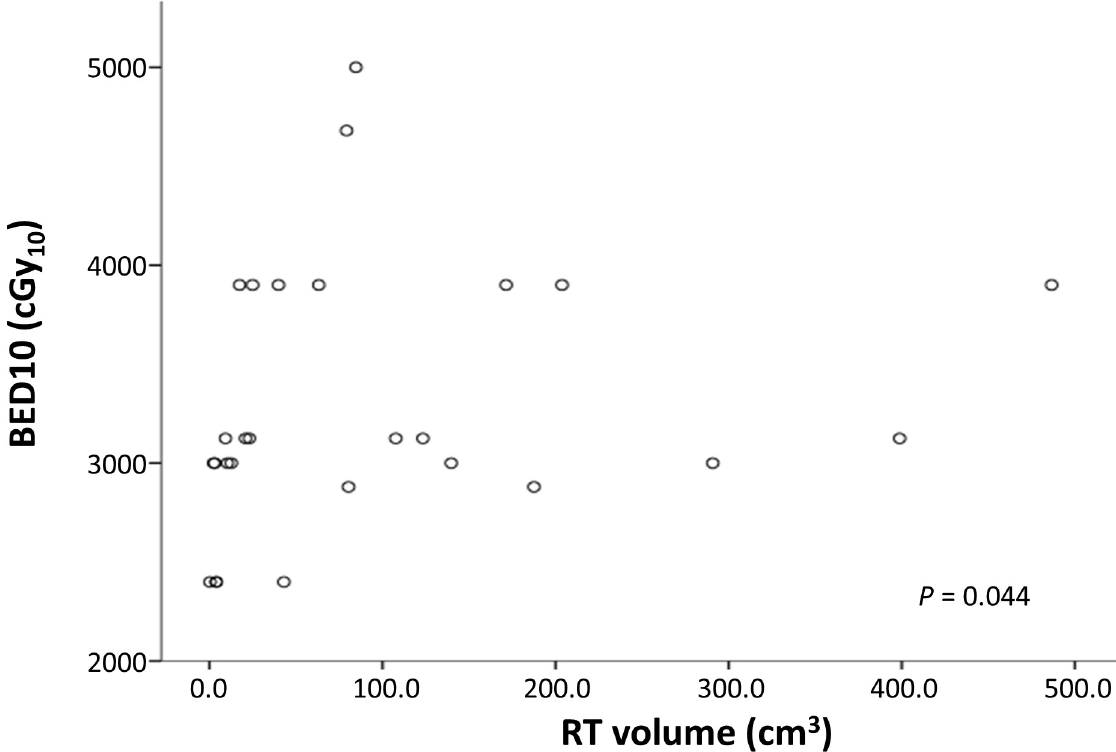
S1 Table. Characteristics of non-responding lesions after